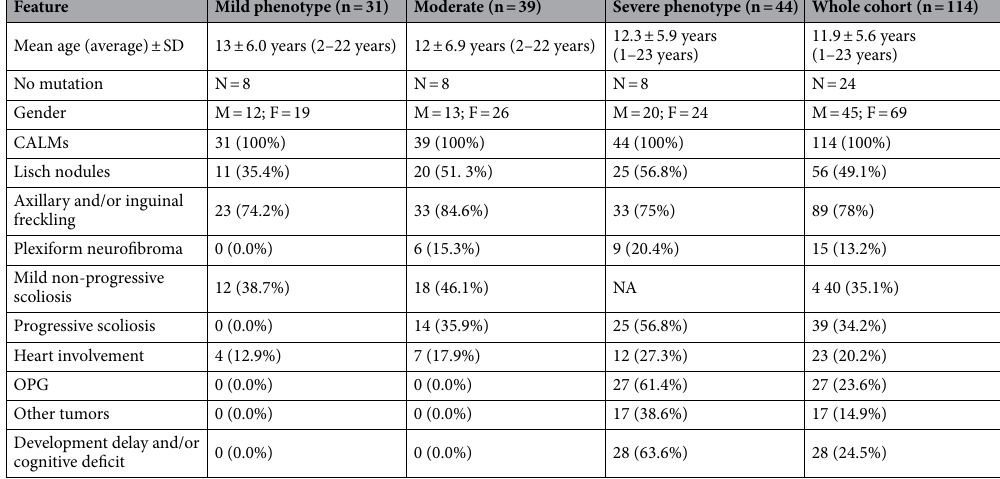
Table 1. Demografic and clinical characteristics of the 114 patients with NF1 included in the study. F females, M males, NA not